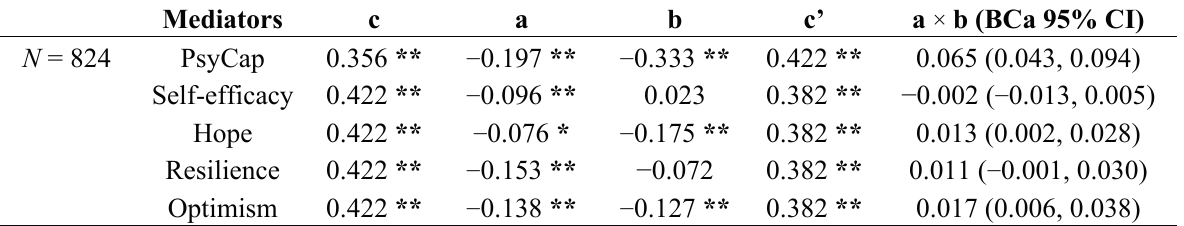
Table 13. FWC as the independent variable and PsyCap and its components as mediators in the regression